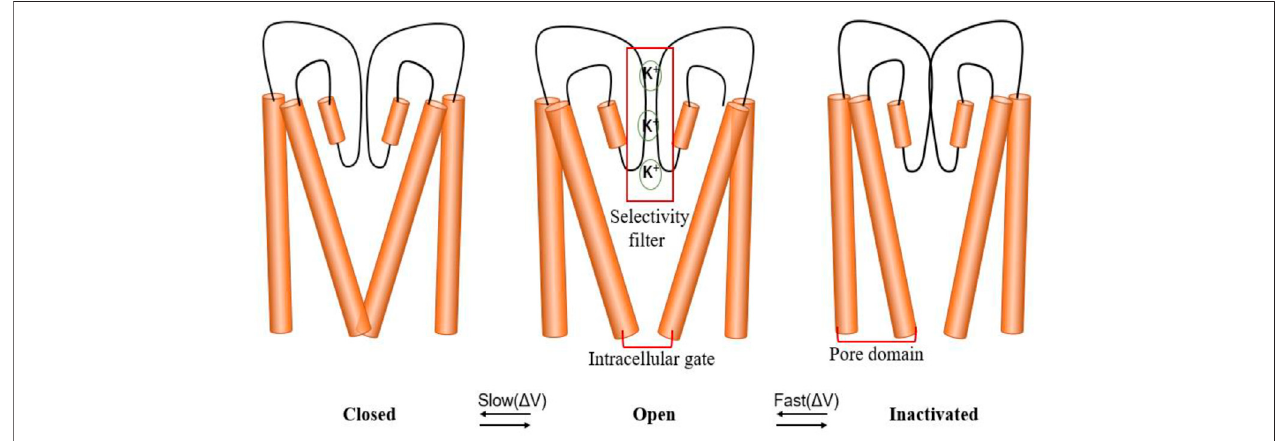
FIGURE3 | hERG channel gating. The channel has three states: closed, open and inactivated. Schematic diagram ofthe hERGchannel gating scheme,indicating that the state transition between closed and open states is slower than the state transition between open and inactive states. The selectivity fi lter (SF), located in the central cavity of the pore domain, and the intracellular activation gate (AG) coupling (AG/SF coupling) are thought to participate in different state changes.